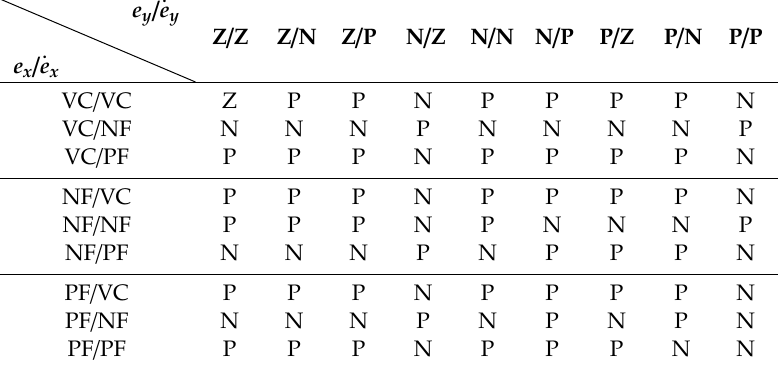
Figure 7 . Membership functions of the input and output variables of the cart controller . Figure 7. Membership functions of the input and output variables of the cart controller. Table 3. Fuzzy logic controllers. Table 3. Fuzzy logic controllers .